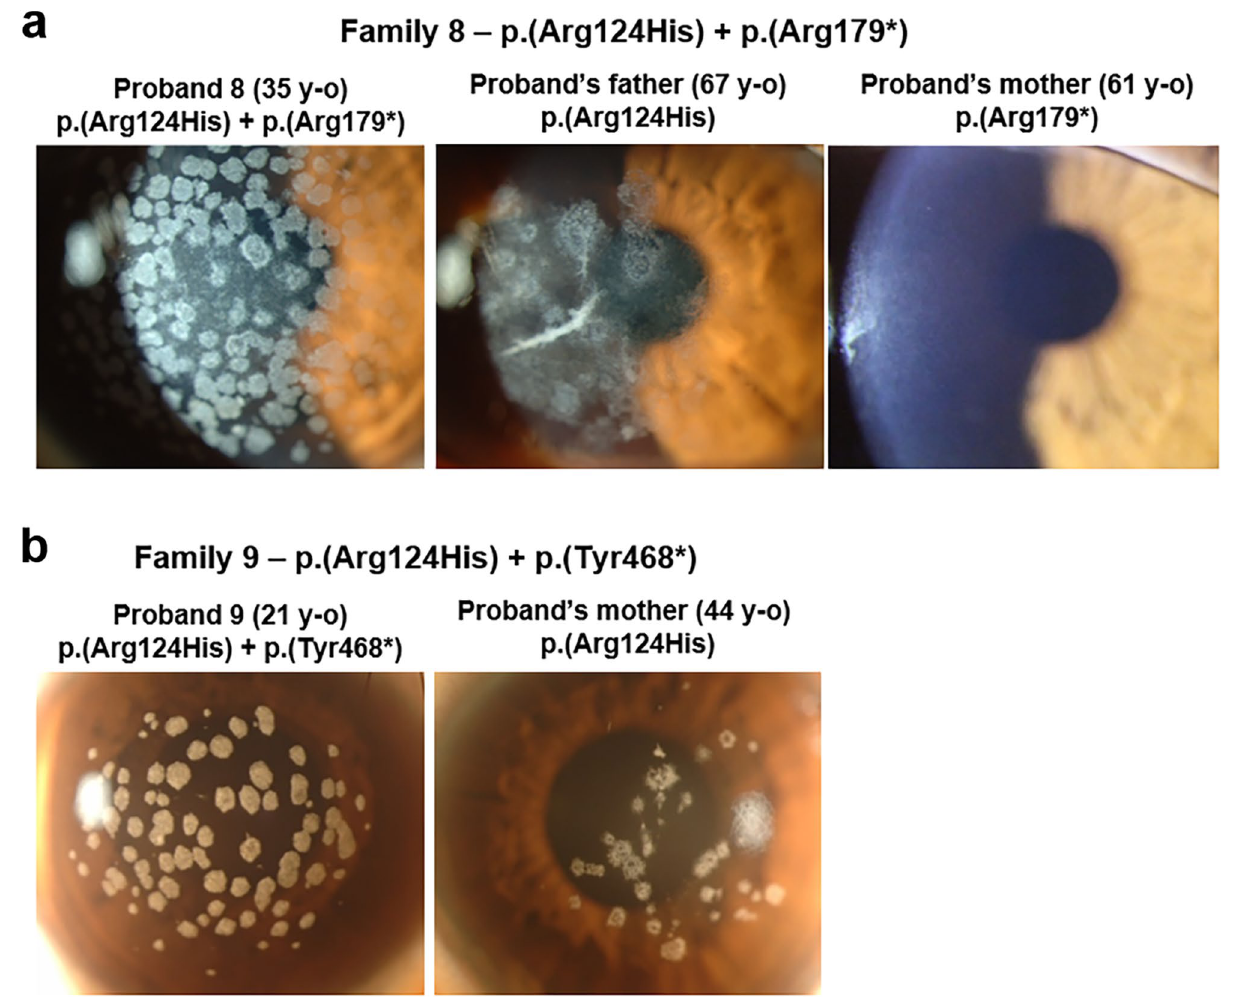
Figure 4. Nonsense mutations of TGFBI (p.(Arg179*) and p.(Tyr468*)) manifested severe granular corneal dystrophy 2 (GCD2) phenotypes. ( a ) Slit-lamp photographs of members of Family 8. Extensive multiple discoid granular deposits, with some annular deposits, were detected, resembling the features of homozygous GCD2 in Proband 8 carrying TGFBI p.(Arg179*) and p.(Arg124His) mutations. Her father carrying heterozygous TGFBI p.(Arg124His) mutation showed milder phenotypes than the proband, and the mother carrying heterozygous TGFBI p.(Arg179*) showed no corneal opacity. ( b ) Slit-lamp photographs of Proband 9 and his mother. Proband 9 harboured compound heterozygous TGFBI p.(Tyr468*) and p.(Arg124His) mutations and showed more severe discoid granular deposits than his mother who harboured heterozygous TGFBI p.(Arg124His)